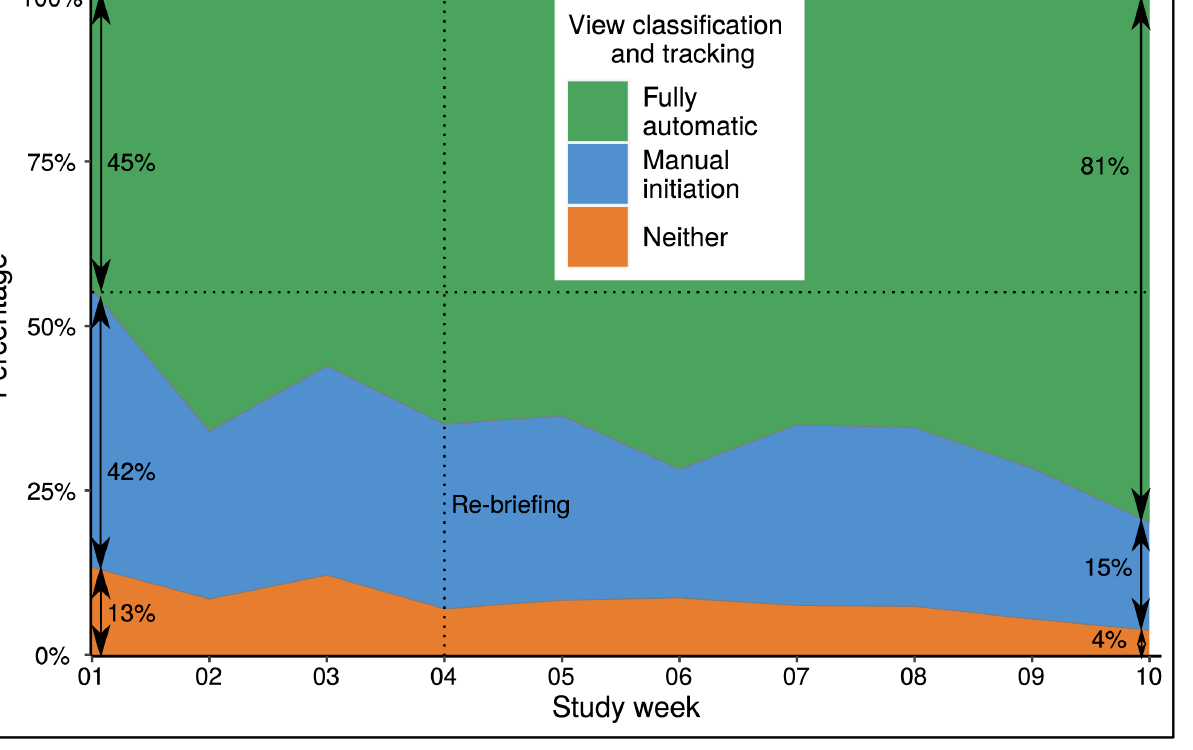
Figure 1. Feasibility of Seamless and Fully Automatic View Selection of LVEF Measurement ( N = 1083). Improving feasibility of fully automatic view selection and LVEF measurement (green) by the AI-based application over the study period of 10 weeks. Manual initiation (blue) was performed in Echo exams with either automatically detected or measured 2- or 4- apical LV chamber views. AI = artificial intelligence; Echo = echocardiography; LVEF = left ventricular ejection fraction.